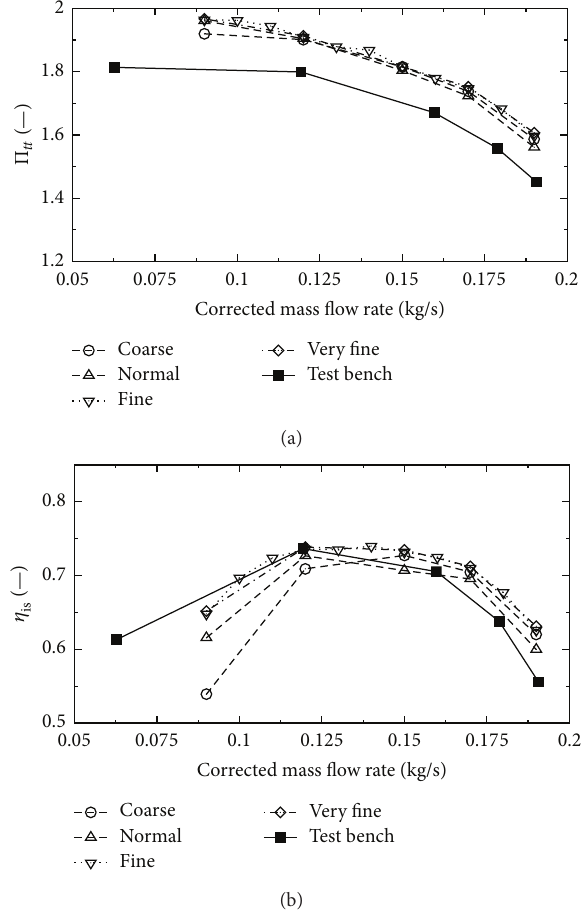
Figure 9: Total pressure ratio and isentropic efficiency for different grid